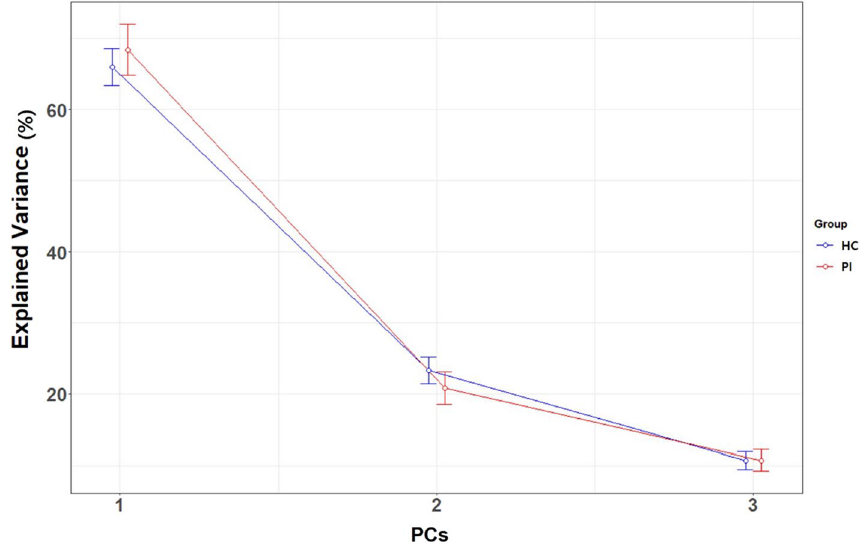
Figure 3. Principal component analysis showing explained variance proportions of the three PCs for ROIbvals of the three contrast images. PCs on the x-axis are ranked in descending order according to the proportions of explained variance of PCs for ROIbvals of the three contrast images (i.e., picture, sound, and Stroop) in the PI (red) and HC (blue) groups. PC1, PC2, and PC3 explain approximately 70%, 20%, and 10% of the total variance of the raw data, respectively.